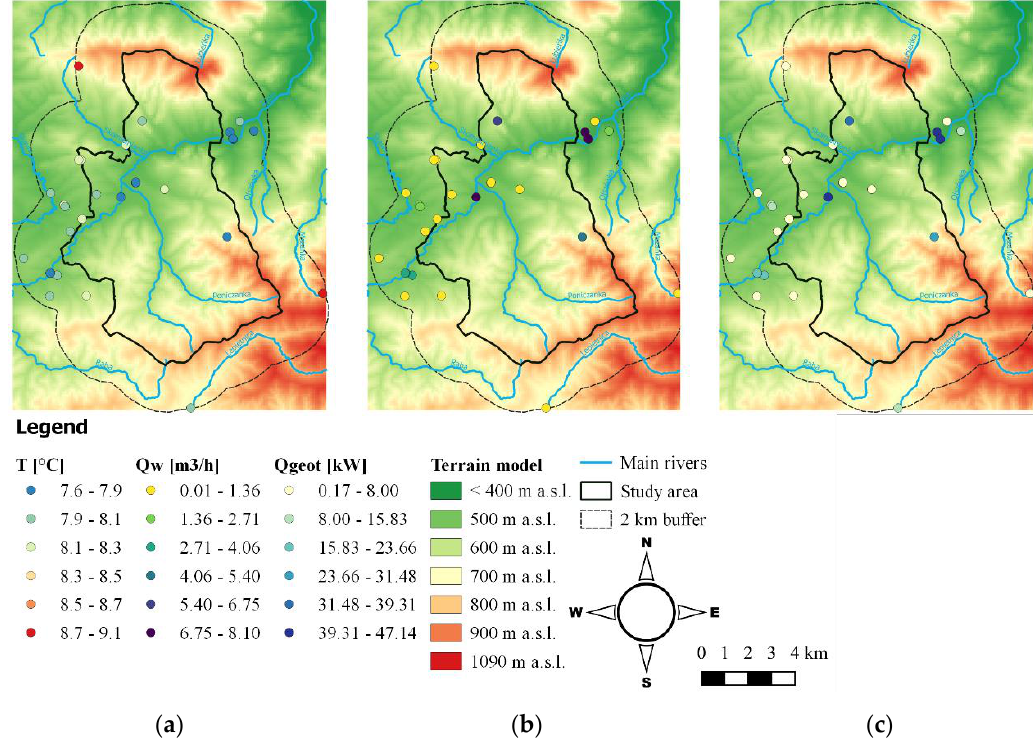
Figure 8. ( a ) Estimated groundwater temperature (°C); ( b ) Efficiency of groundwater intakes (m 3 /h); ( c ) Estimated heating power of intakes (kW). Table 3. Values of physicochemical parameters of the analyzed